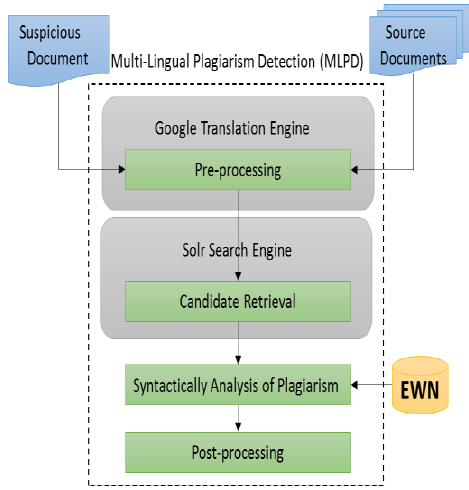
Figure 10. Percentage of results of comparison made between each sentence and google translation